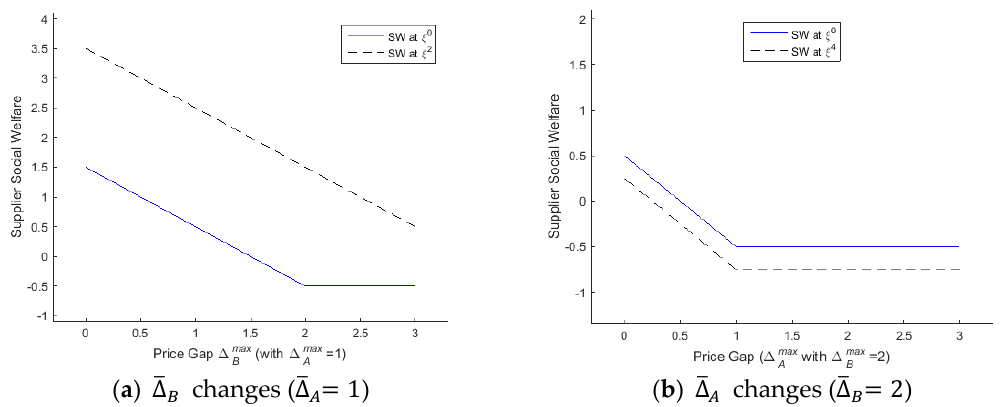
Figure 7. Suppliers’ SW changes as the respective maximum pricing margins vary.